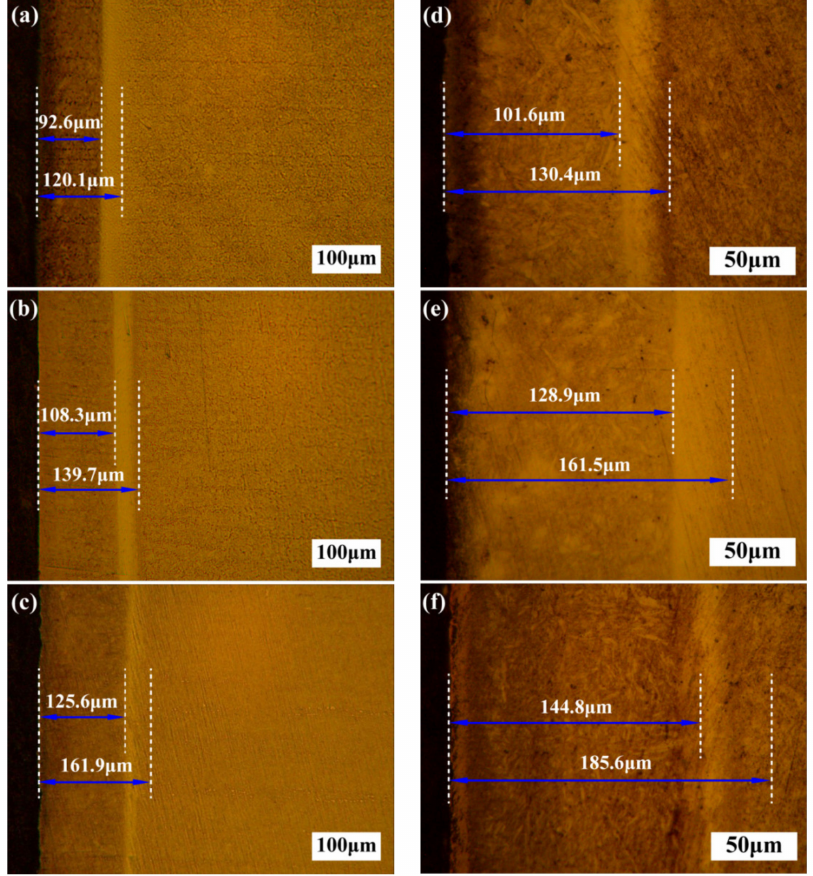
Figure 1. Cross-section micrograph of modified layer of 3Cr13 steel after plasma nitriding ( a ) h4, ( b ) h8, ( c ) h12 without RE and ( d ) h4, ( e ) h8, ( f ) h12 with